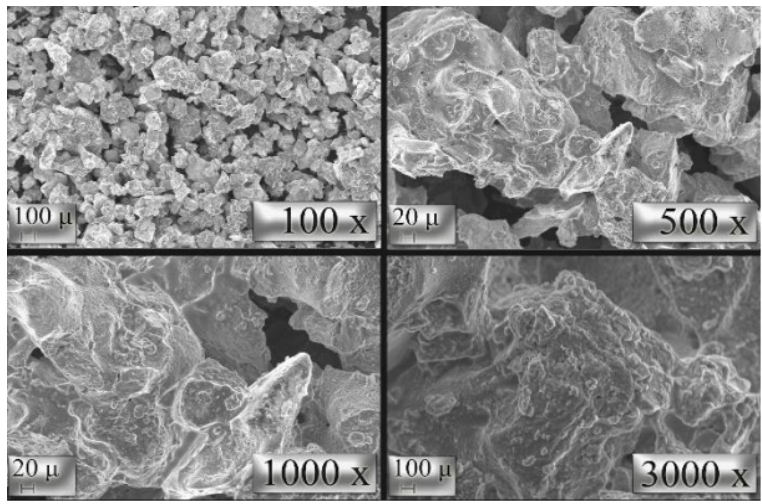
Figure 4. SEM micrograph of AC at a magnification of 100 to 3000 ×.